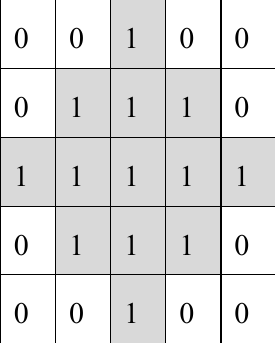
Figure 3. 5 × 5 mean contiguity filter applied in CA Markov